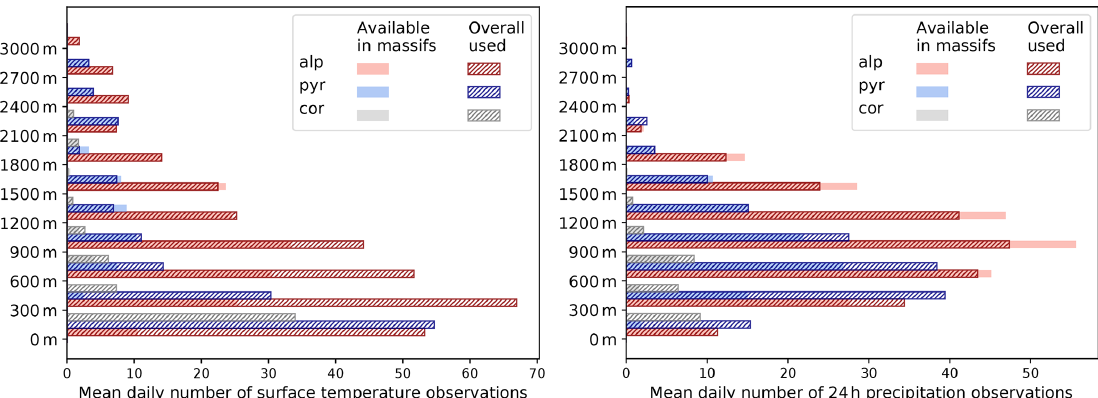
Figure 5. Mean daily number of 2m temperature and 24h precipitation observation sites available (plain colors) and used (hatches) to produce the S2M reanalysis in every 300m elevation band for the French Alps, Pyrenees and Corsica on average for the 1958–2020